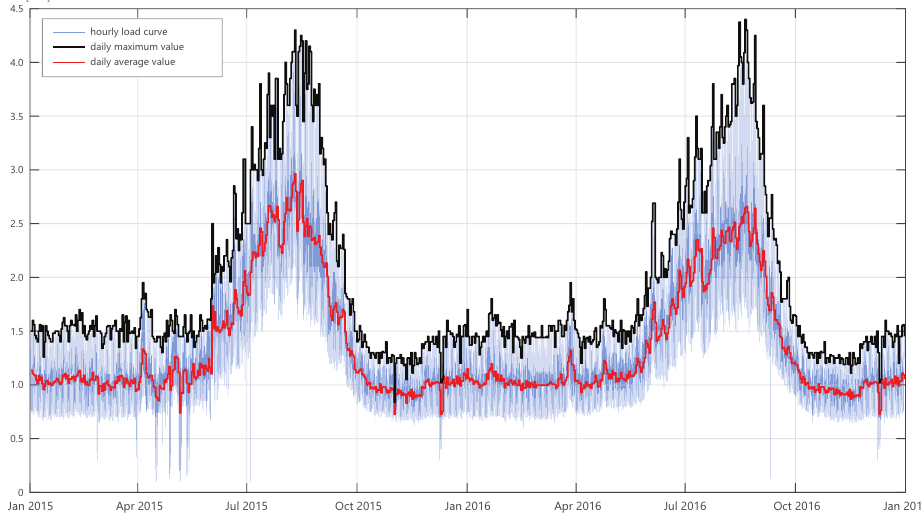
Figure 2. Hourly load curve for the years 2015 and